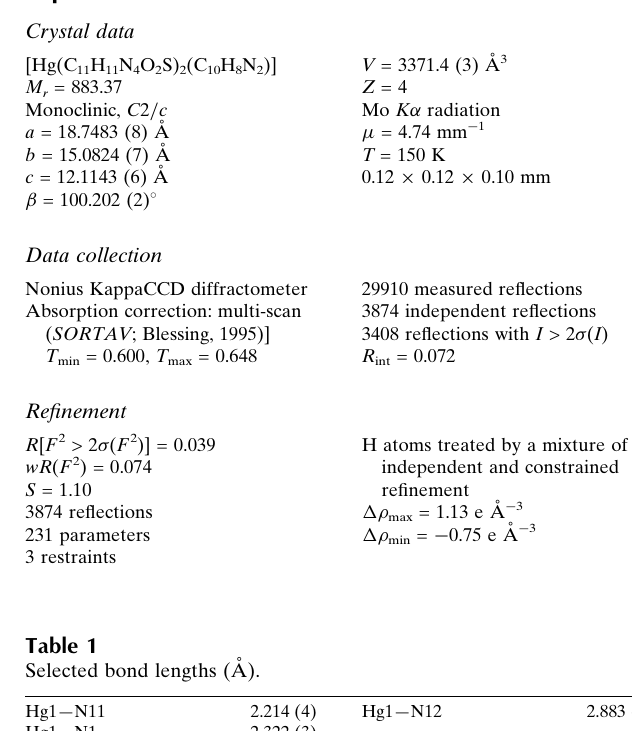
Selected bond lengths (A˚ ).